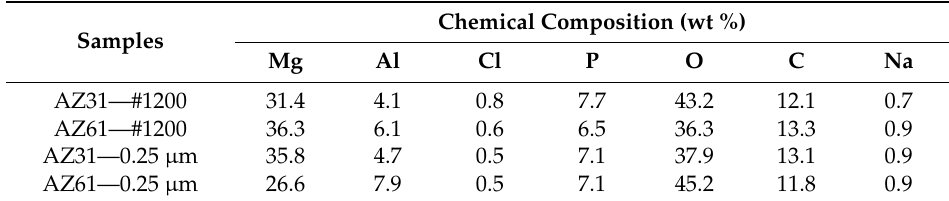
Table 7. Chemical composition of corrosion product on the surface of AZ31 and AZ61 magnesium alloys after EIS measurements in HBSS (without Mg 2+ and Ca 2+ ions).